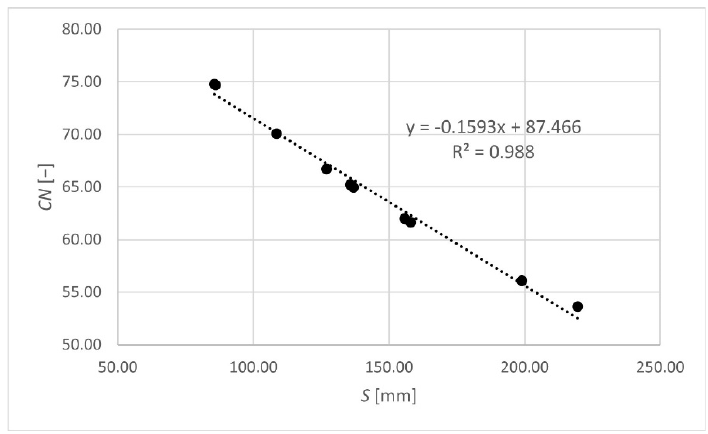
Figure 7. Correlation between the CN parameter and retention amount (S).